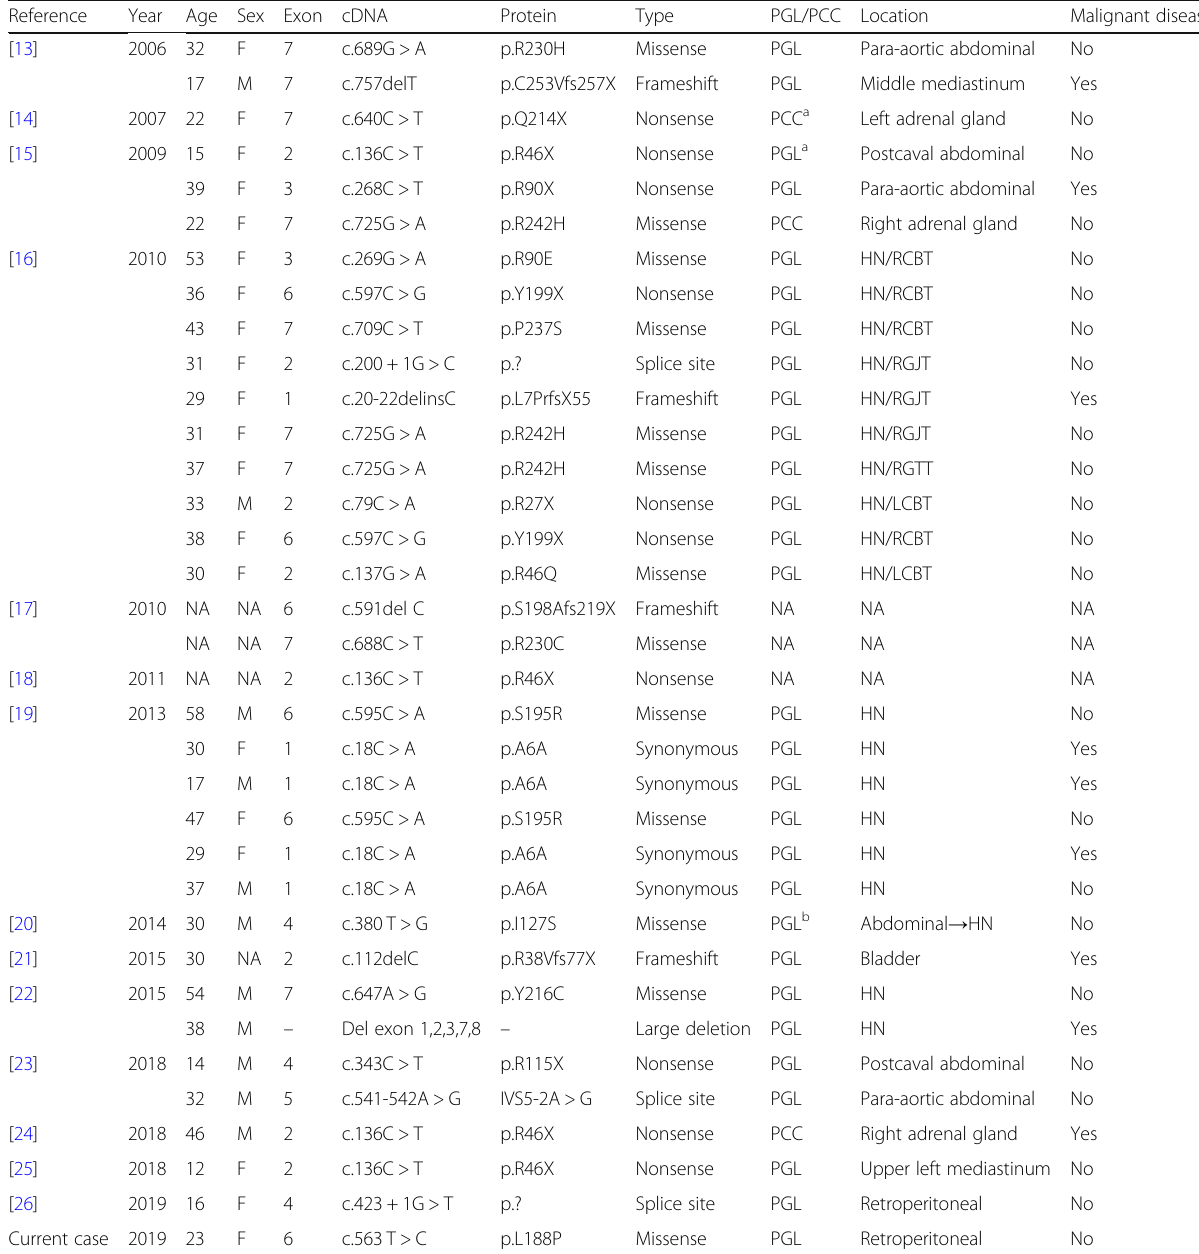
Table 2 Characterization of Fifteen Related Studies on SDHB Mutations in PPGL Patients